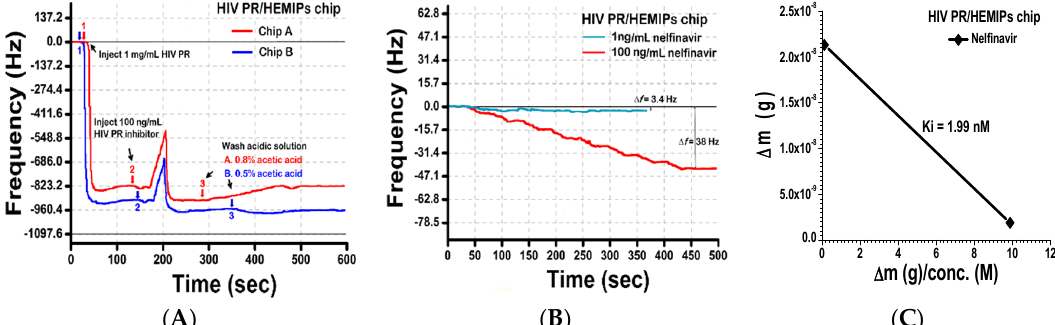
Figure 5. The detection of a HIV PR/HEMIPs chip for HIV PR and the screening of its inhibitor nelfinavir. ( A ) Frequency shifts of injecting HIV PR and its inhibitor nelfinavir solution into a HIV PR-HEMIPs chip, followed by washing with different concentrations of acetic acid solution as detergent. ( B ) Reuse of the HIV PR/HEMIPs chip towards 100 μ L of 1 ng/mL and 100 ng/mL nelfinavir after washing with 0.8% acetic acid solution. ( C ) Ki value for the binding of the inhibitor to the HIV PR. ∆ m, the mass diff erence on the quartz surface.